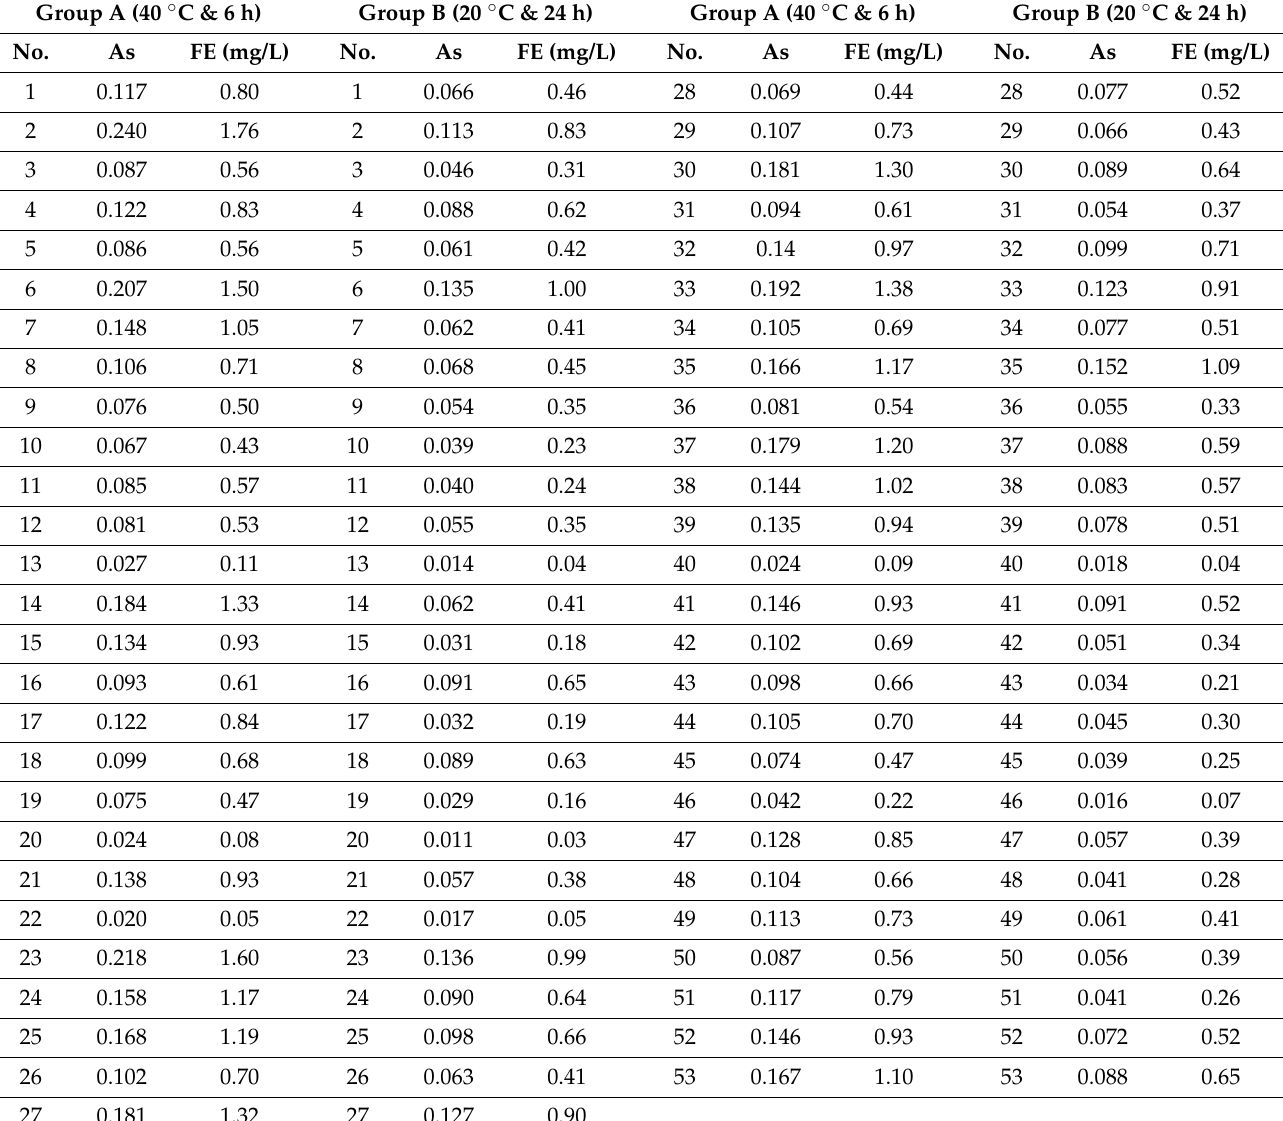
Table 3. Formaldehyde emissions data measured by the desiccator at 40 ◦ C for 6 h and 20 ◦ C for 24